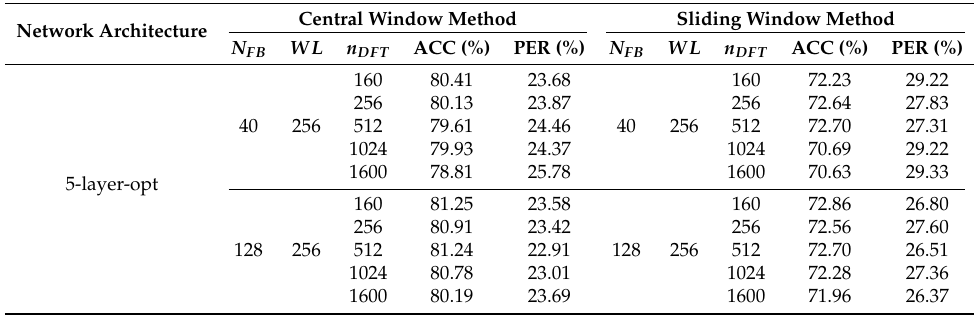
Table 4. Accuracy of the optimized 5-layer network in spectrogram-window classification (ACC) as well as in phoneme recognition